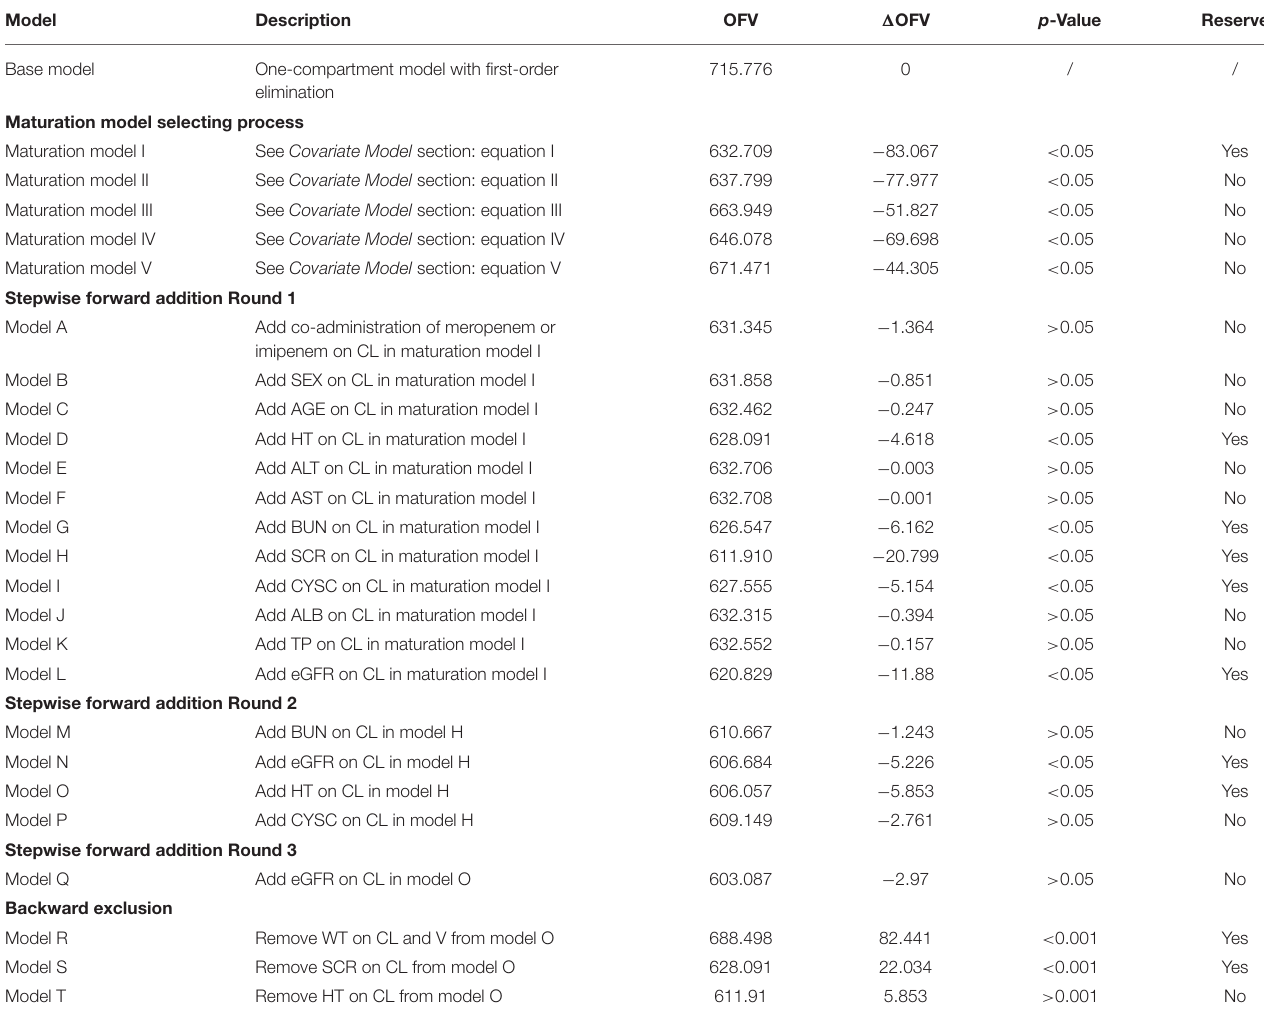
TABLE 4 | The covariate model building process of Model 1.